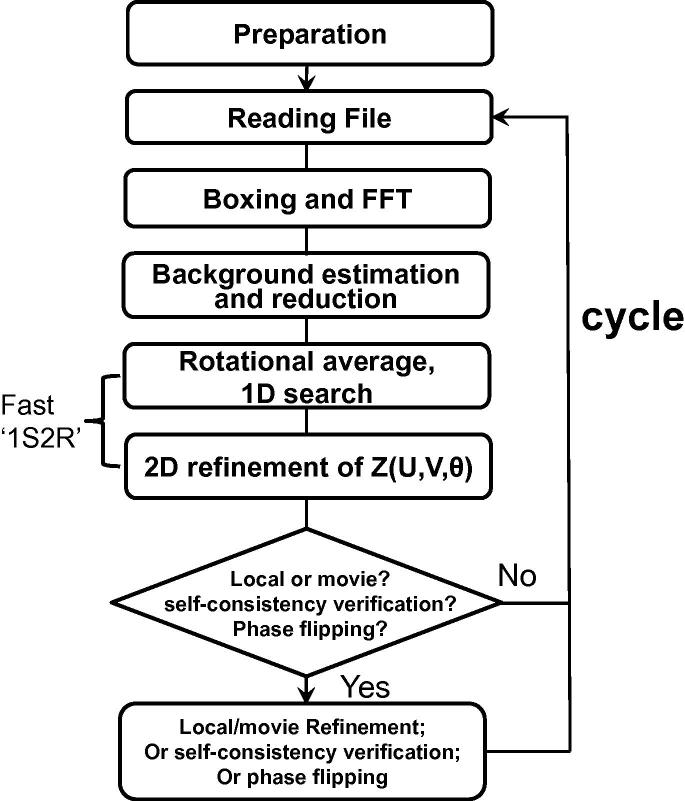
Flow chart of Gctf.